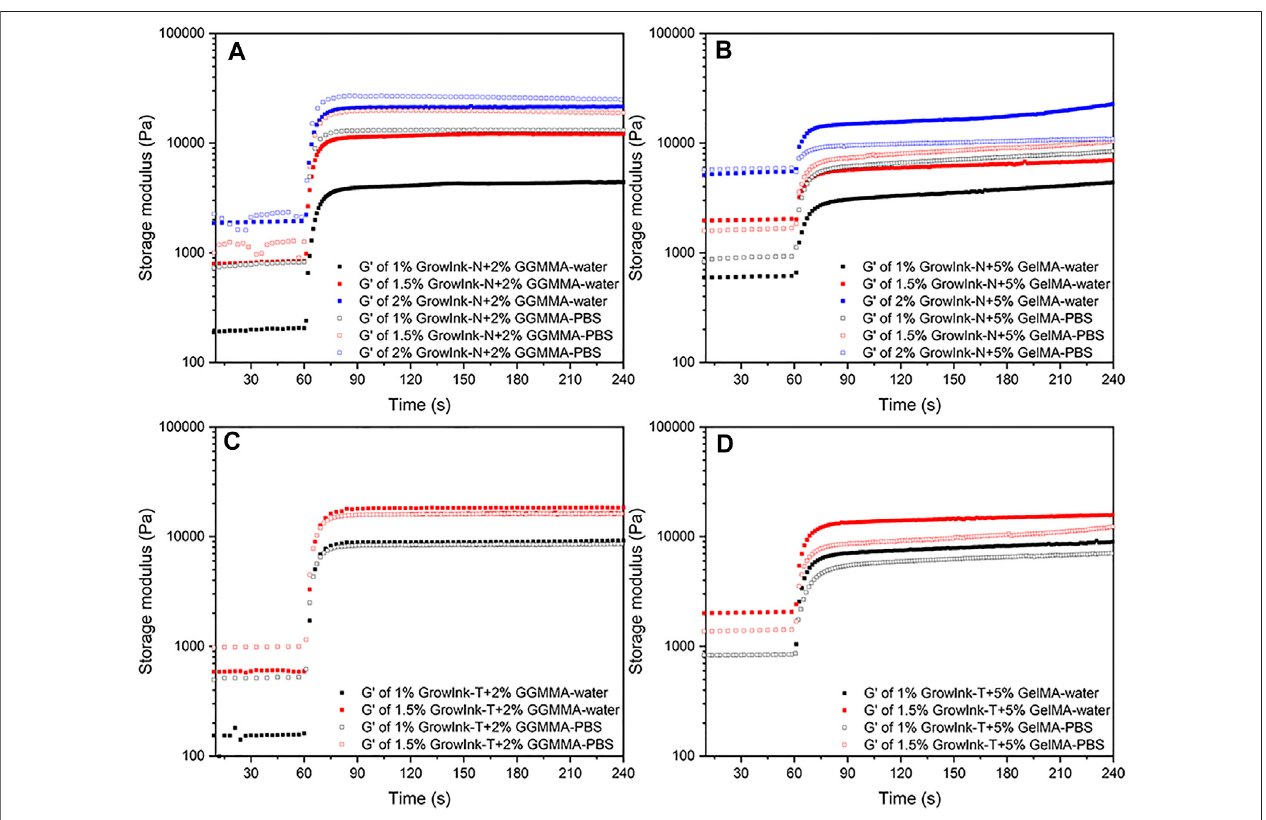
FIGURE 5 | Photorheology pro fi les of the formulated inks: (A) GrowInk-N-GGMMA – based inks, (B) GrowInk-N-GelMA – based inks, (C) GrowInk-T- GGMMA – based inks, and (D) GrowInk-T-GelMA – based inks diluted with PBS or water, respectively.